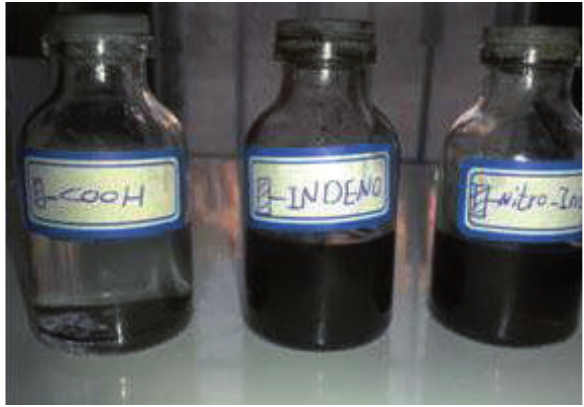
F 9: e images of A MWNT-COOH, B MWNT-(11H- indeno[1,2-b]quinoxaline-11-ylidene)benzene-1,4-diamine, and C MWNT- (8-nitro-11H-indeno[1,2-b]quinoxaline-11-ylidene) benzene-1,4-diamine in DMF (1mg/6mL) aer standing for 1